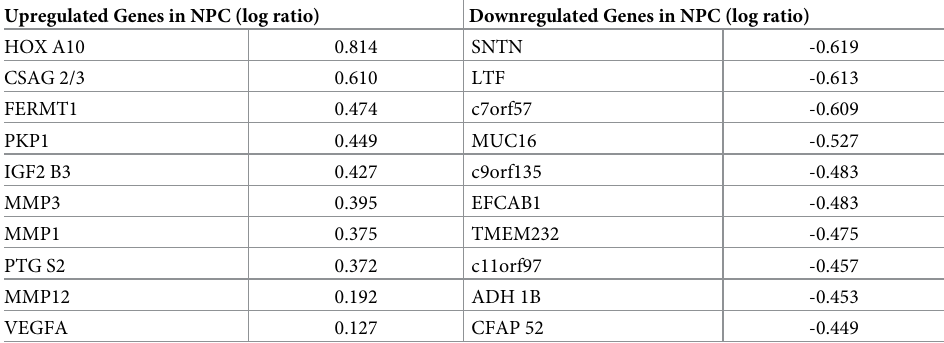
Table 1. Top upregulated and downregulated genes between normal and NPC tissue along with their correspond- ing experimental log ratios. Upregulated Genes in NPC (log